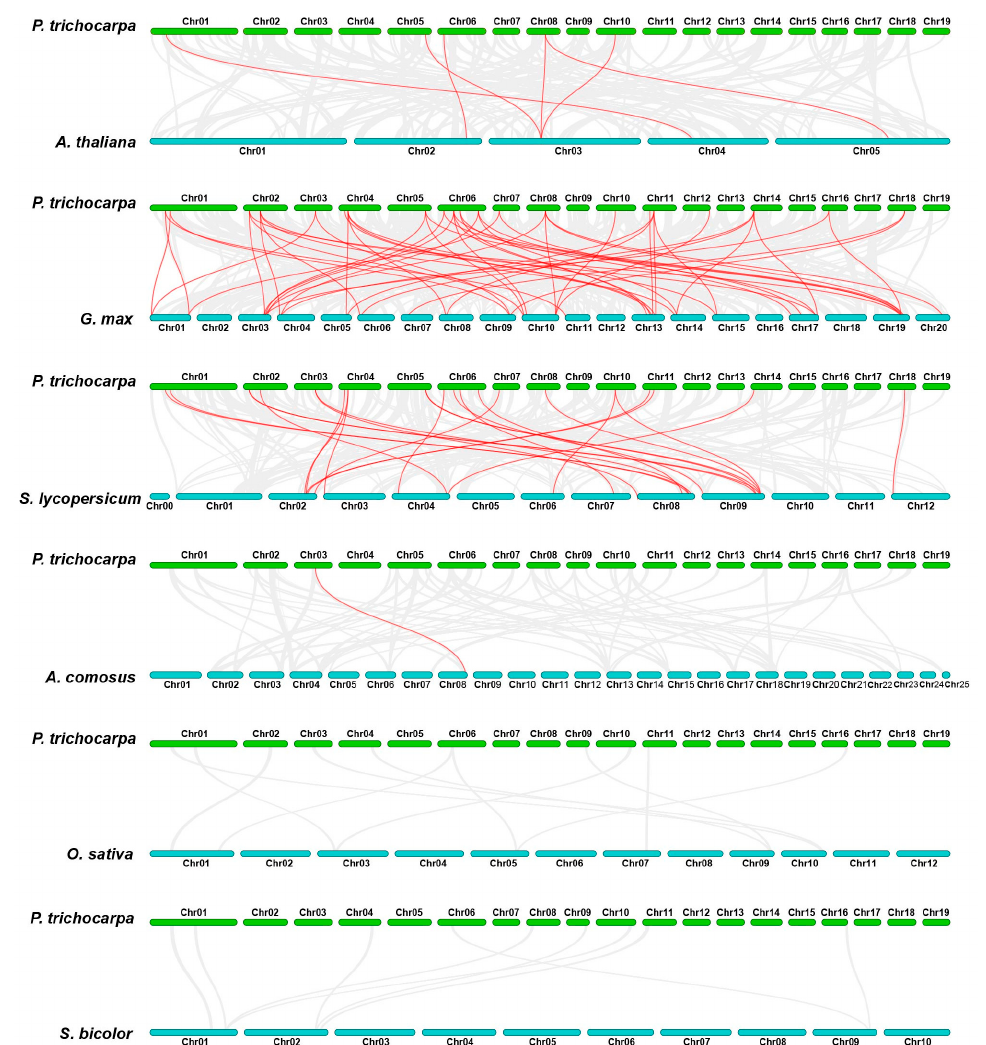
Figure 7. Collinearity analysis between the poplar HSF genes and the genes of six other plant species. Gray lines indicate collinearity blocks that are homologous to other genomes in poplar. The red lines represent gene pairs with collinearity relationships.